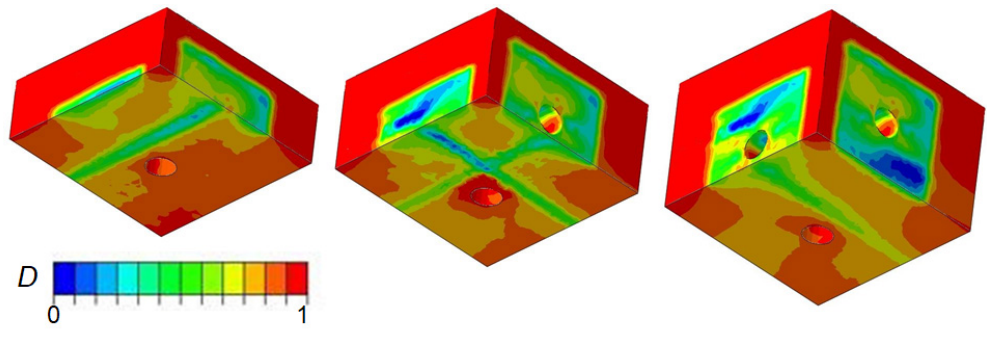
Figure 5. Contour plot of damage at the end of the biaxal expansion test in different sections of the